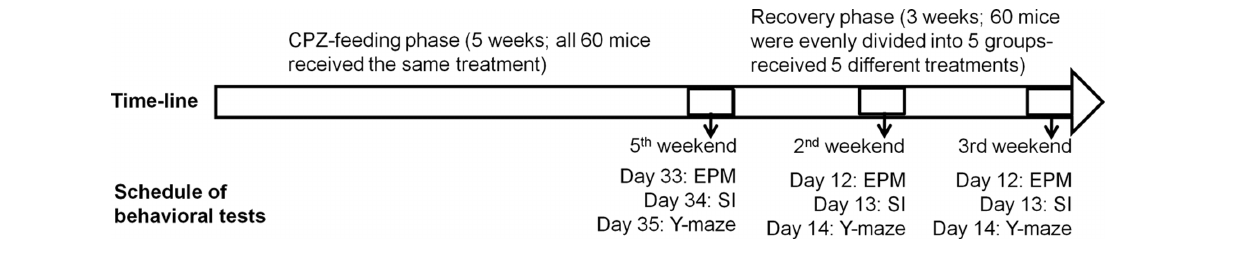
Figure 1 | The time-line and schedule for the behavioral tests in experiment. CPZ, cuprizone; EPM, elevated plus-maze; SI, social